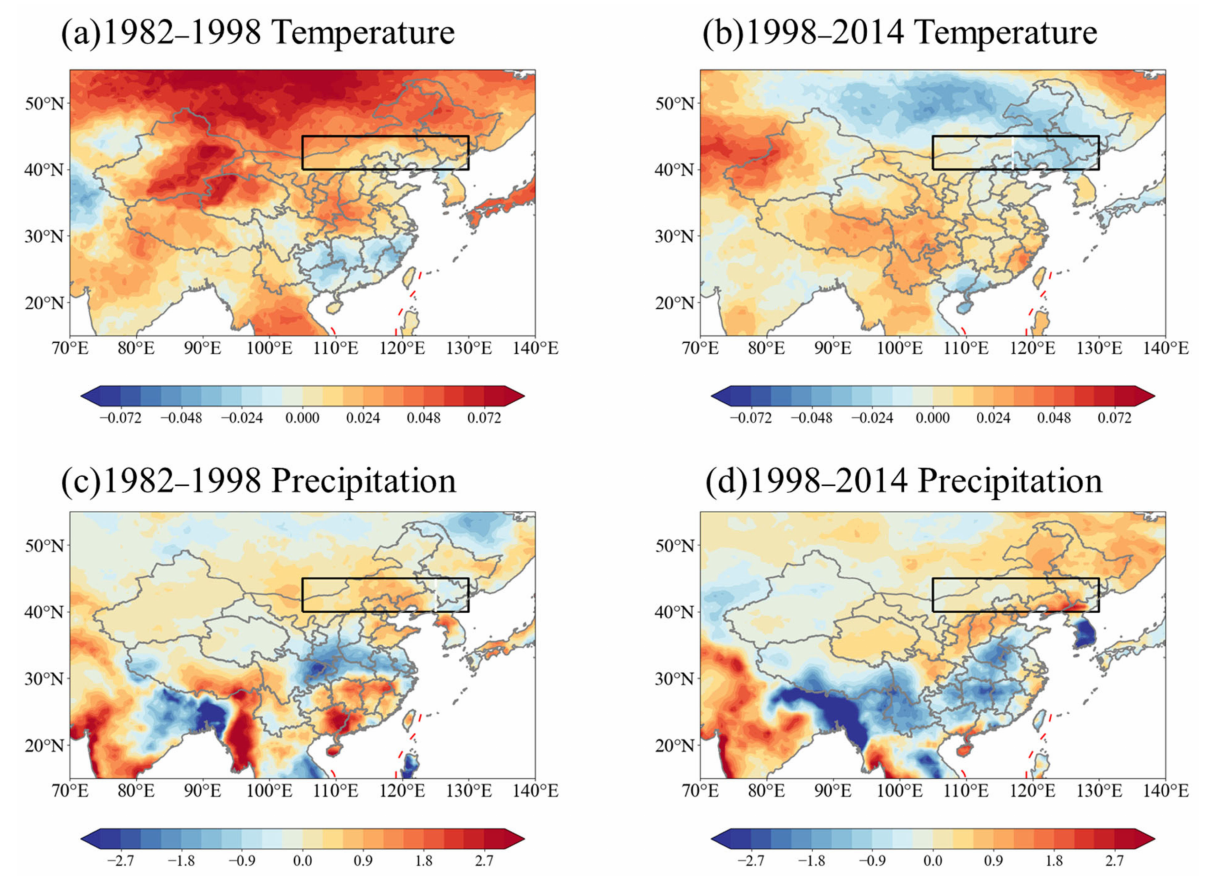
Figure 3. Analysis of temperature ( ◦ C) and precipitation (mm) trends for different periods. Note: Warm tones represent an increasing trend, cool tones represent a decreasing trend. The red dashed lines in the figure represent Ten-dashed lines. The numbers below the description of the colors represent the trend slope value. The black box in it is defined as the northeastern region of East Asia (40~45 ◦ N, 105~130 ◦ E) and the white line in ( b ) represents longitude of 117 ◦ E.